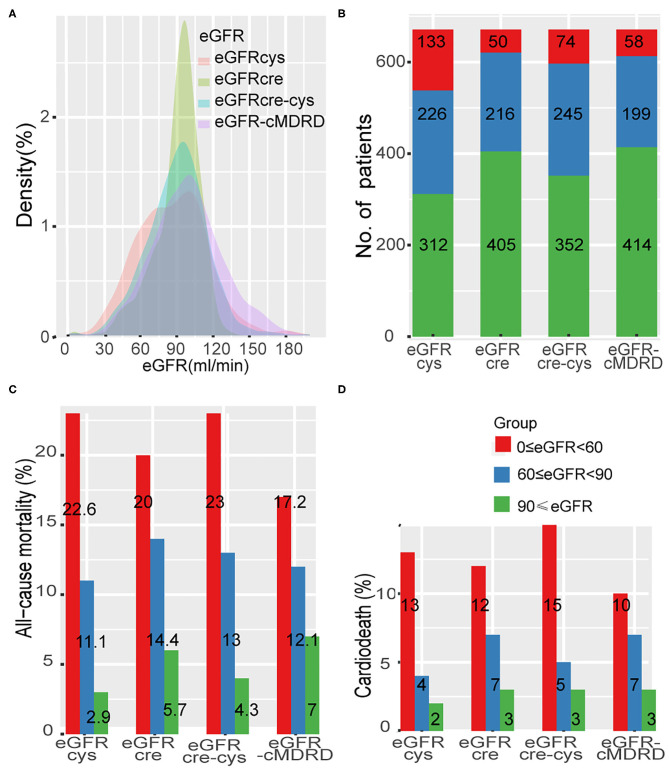
Distribution of eGFR and the rate of adverse event across different renal levels. (A), Distribution of eGFR according to each of the four equations in a density plot. (B), Thresholds of eGFR according to each equation and number of patients in each CKD stage. (C,D), Incidence of all-cause mortality and cardiac death at different renal levels by different formulas. eGFR-cMDRD, calculated by MDRD for Chinese equation. eGFRcre, CKD-EPI equations composed of eGFR from serum creatinine; eGFRcys, eGFR from serum cystatin C; eGFRcre-cys, eGFR from equation incorporating both creatinine and cystatin C.